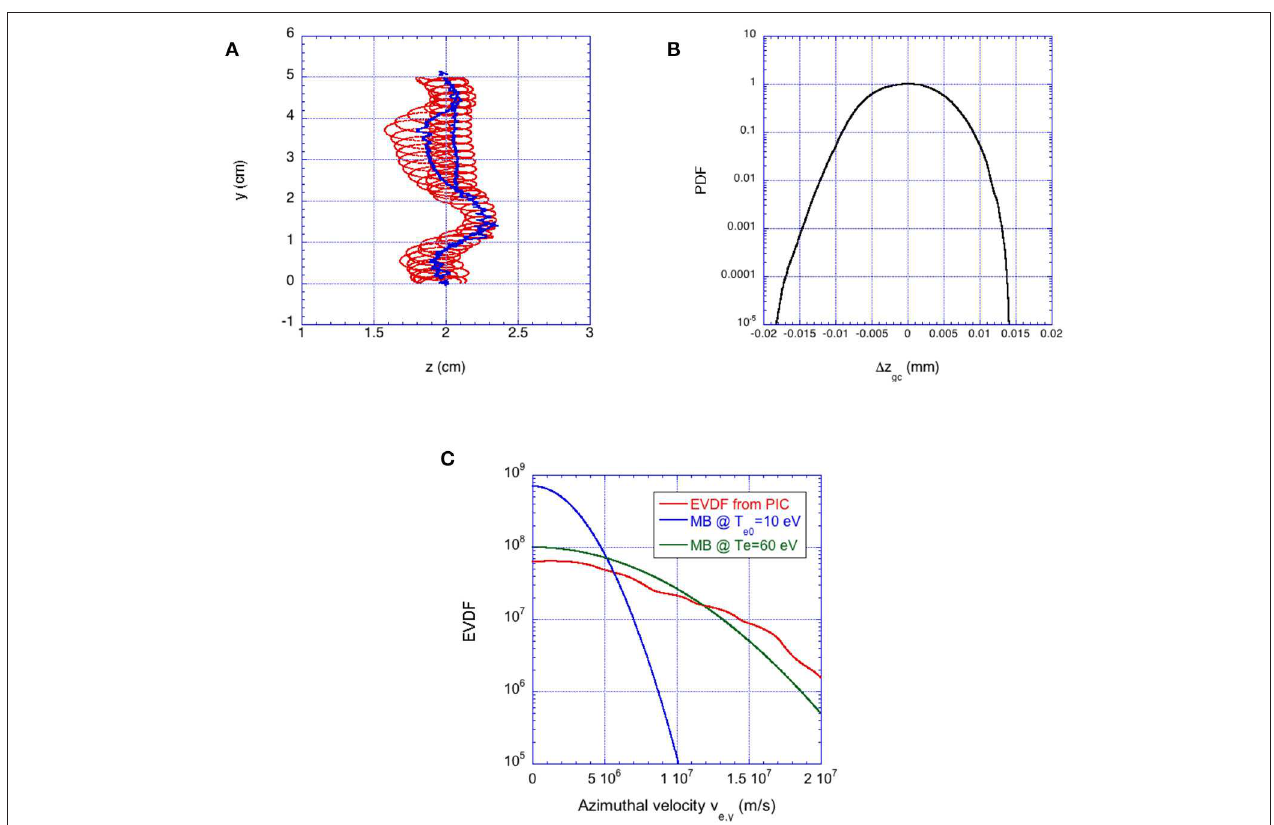
FIGURE 7 | (A) Trajectory of a sampled electron (red curve) and its guiding center (blue curve) during the non-linear phase (total sampling time corresponding to 0.1 µ s). (B) Probability distribution function (PDF normalized to the maximum) of the electron guiding centers jump size 1 z gc . (C) Azimuthal velocity distribution function of electrons at t 12 µ s (red curve). The Maxwell distribution functions given as reference have the initial temperature set in the model T e0 = equivalent temperature from best fitting the computed distribution (green